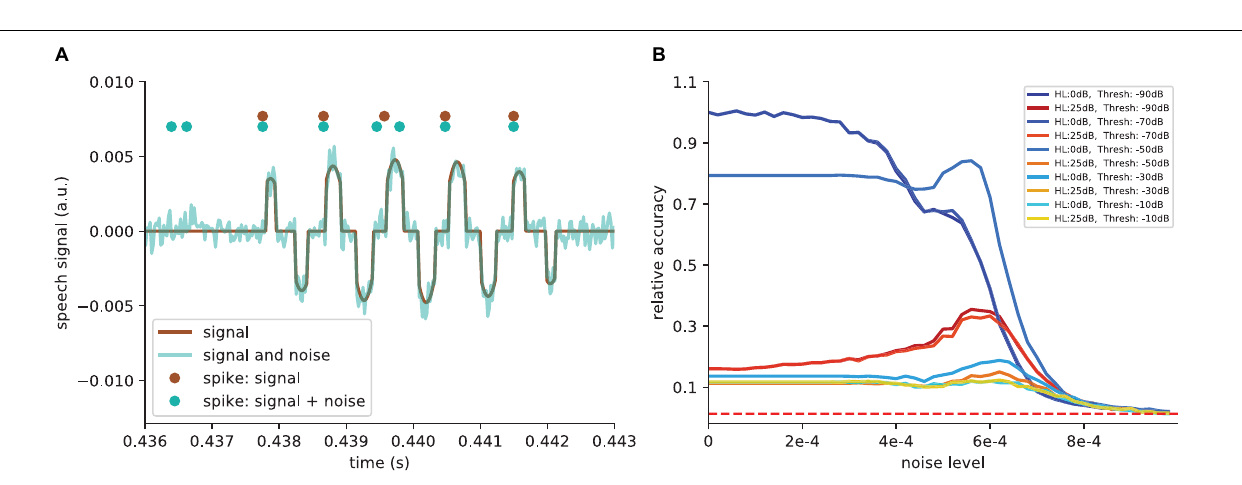
FIGURE 9 | SR effect with additional threshold. (A) Example of signal after simulated cochlea for one frequency channel and an additional threshold of − 50 dB ( − 50 dB means that all values above − 10 − 50 20 and below 10 − 50 20 ≈ 0.003 are set to zero). This threshold is introduced to show that the SR effect also works when hearing loss leads to a real information loss. The noise leads to a signal enhancement (cyan curve). Thus, the signal causes more spiking in the DCN (cyan dots compared to brown dots). (B) Relative accuracy as a function of the amplitude of the added noise. SR resonance partly restores the accuracy. For very high thresholds, where main parts of the signals are deleted, the SR does not restore the